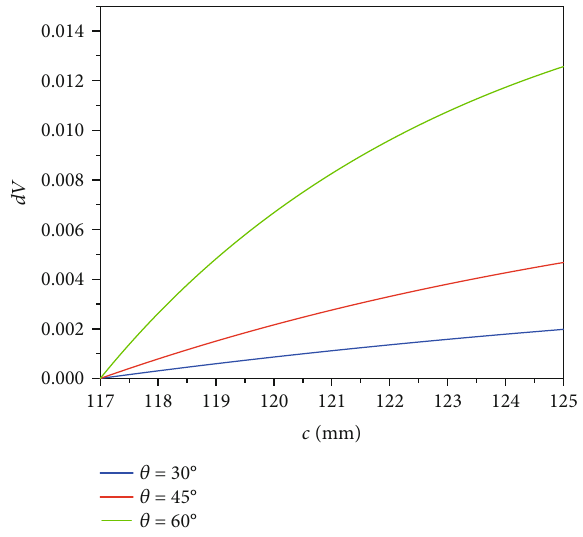
Figure 9: dV at di ff erent